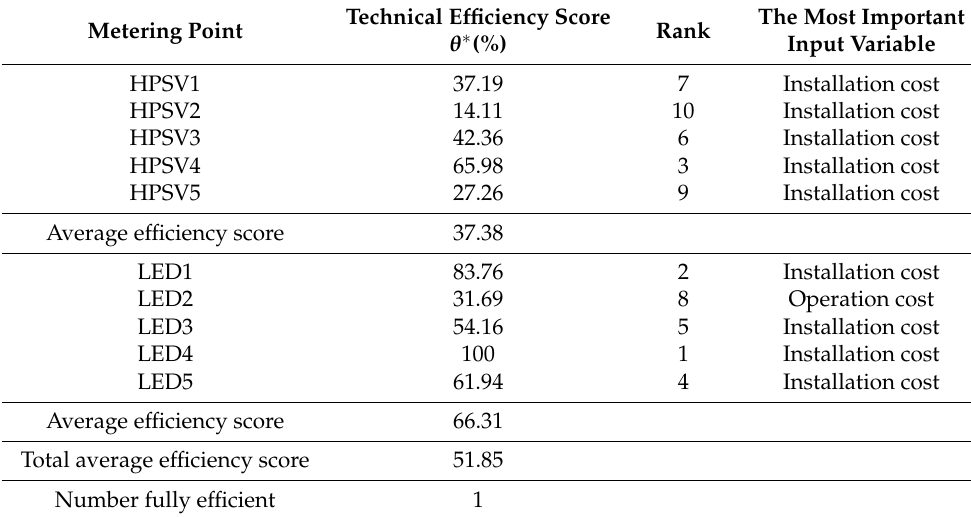
Table 7. Results of the DEA technical efficiency score, rank, and the most important input variables for HPSV and LED Road